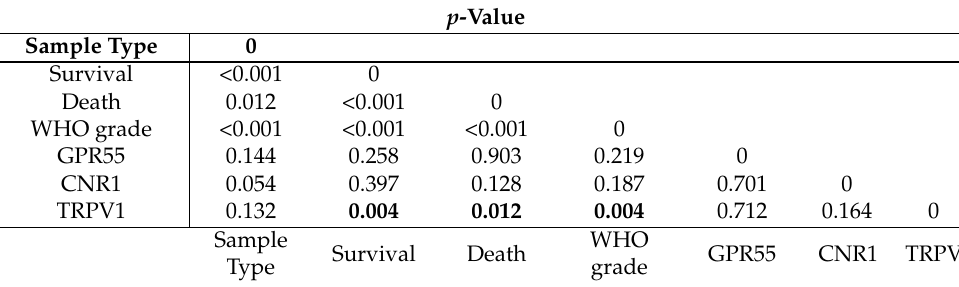
Table 1. Significance of correlations in Figure 2A.